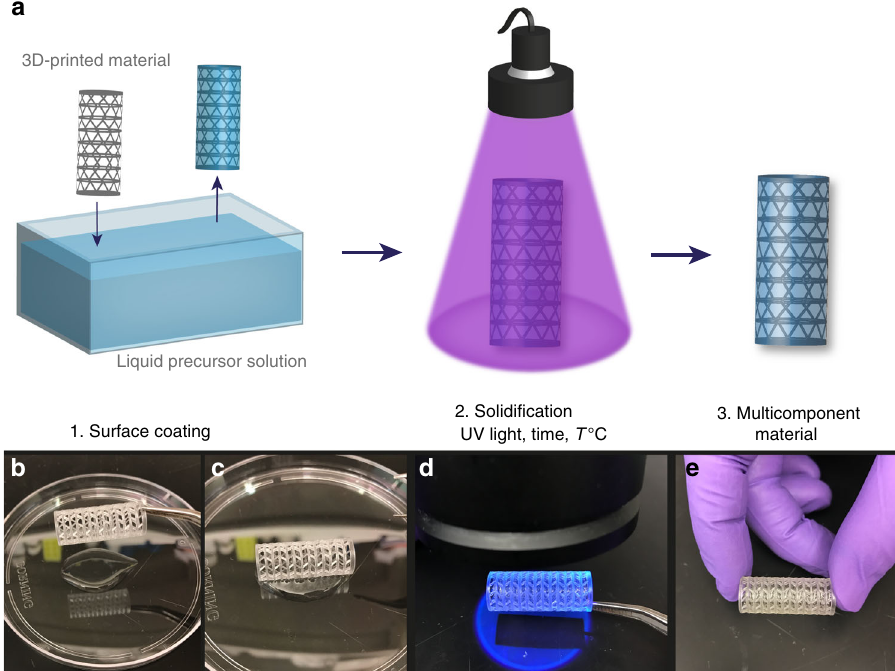
Fig. 1 Surface tension-assisted additive manufacturing. a Schematic of the material fabrication process. b The 3D-printed reticulated scaffold is dipped into a liquid precursor solution. c Surface tension forces suspend a liquid fi lm on the surface of the scaffold as the scaffold is withdrawn from the solution. d The suspended liquid fi lm is crosslinked into a solid fi lm by, for example, photopolymerization. e A stable solid coating is formed on the 3D-printed reticulated